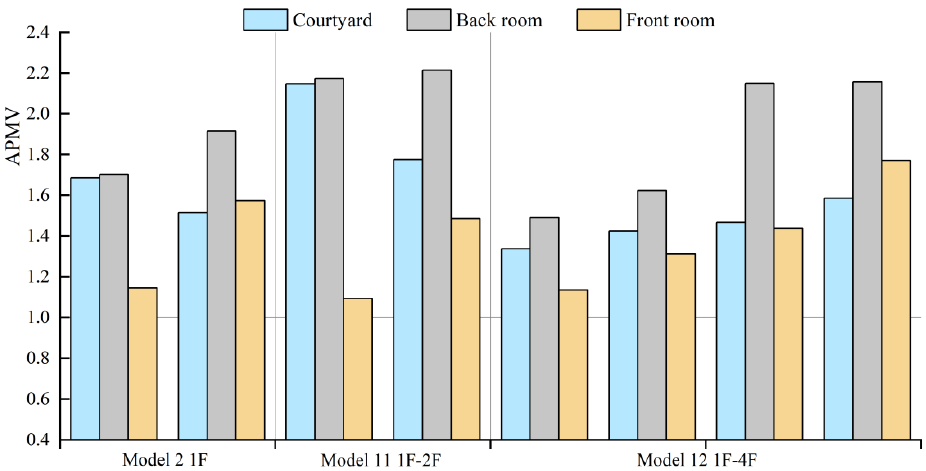
Figure 14. APMV values in Models 2, 11, and 12 at 12:00 at 1.2 m height on each floor. Through the above three simulations, the internal courtyard configuration design guidelines of LSH are formed, as shown in Table 7.